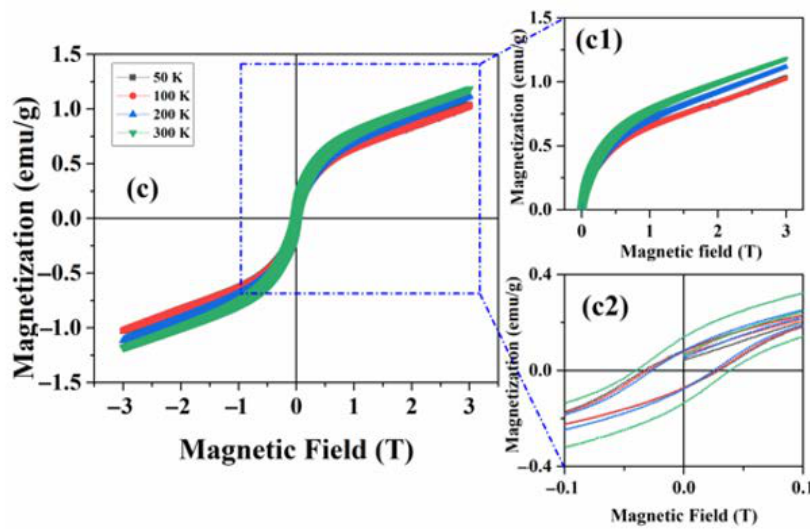
Figure 5. Comparison of different figure of merits at 50 K, 100 K, 200 K and 300 K isotherms for ( a ) FNN-221 and ( b ) FNN-211 ( c ) α -Fe 2 O 3 . ( a1 , a2 , b1 , b2 , c1 , c2 ) are the corresponding local magnified image of magnetization curves representing the behavior of total magnetization and coercivity with respect to the temperature.